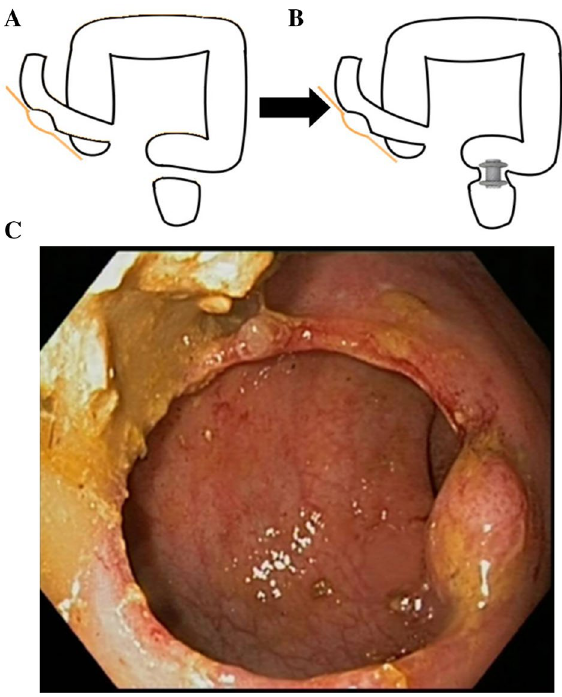
Figure 1. Graphic scheme of the patient’s anatomy ( A , left) and the site of LAMS. placement ( B , right). ( C ) Endoscopic colorectal anastomosis after removing the LAMS. Currently permeable 12 months after stent